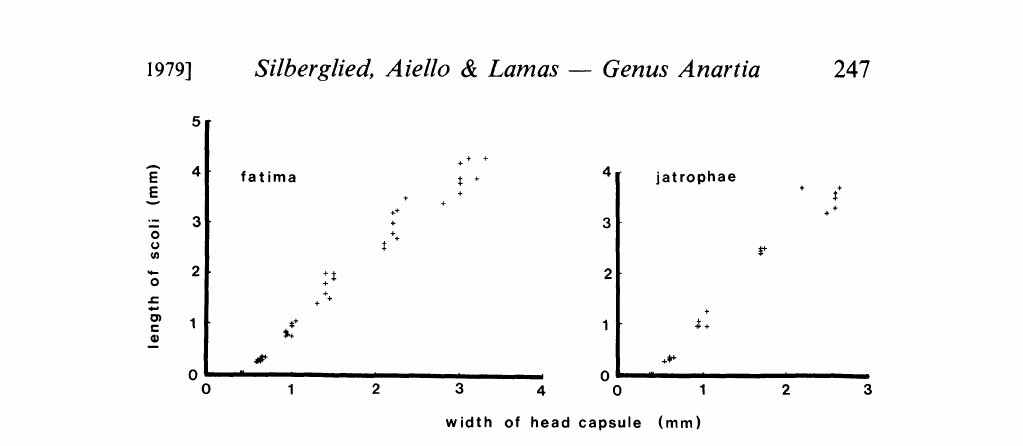
Figure 8. Dimensions of head capsules and scoli of the larvae of A. fatima and A. jatrophae, reared individually. Note that A. jatrophae has one less instar, but grows more per instar, than A. fatima. However, the final larval head capsule size of A. jatrophae is not quite as large as that of A. fatima. [Instar lacks scoli.]